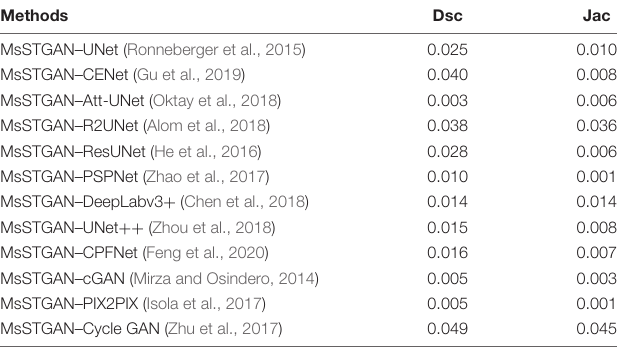
TABLE 3 | Statistical analysis ( p -value) of the proposed MsST-GAN compared with other convolutional neural network (CNN)-based methods. Methods Dsc